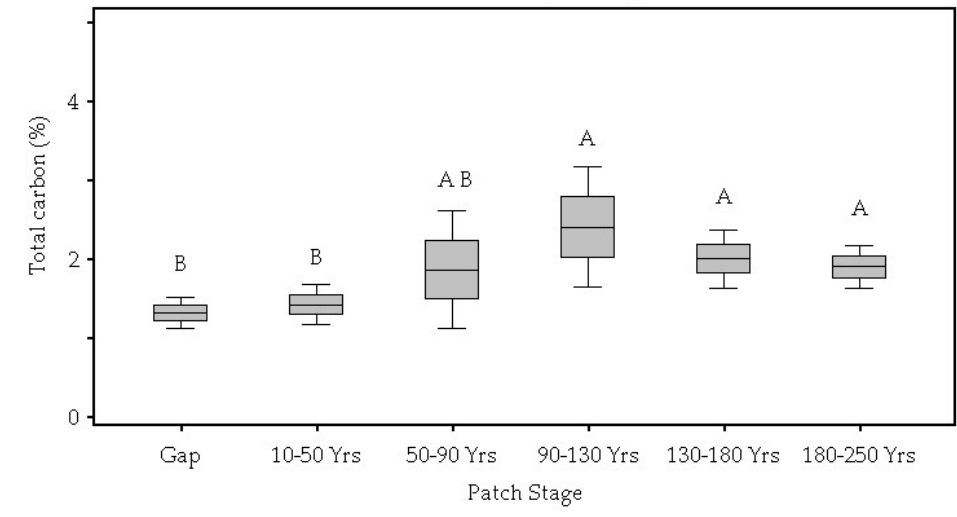
Figure 6. Total soil carbon in patch stages. Total percent of soil carbon in plots in each patch stage ( n = 10). Boxes represent plot distribution within one standard deviation of the mean (box center line). Error bars indicate standard error and shared letters indicate non-significant differences among patch stages.